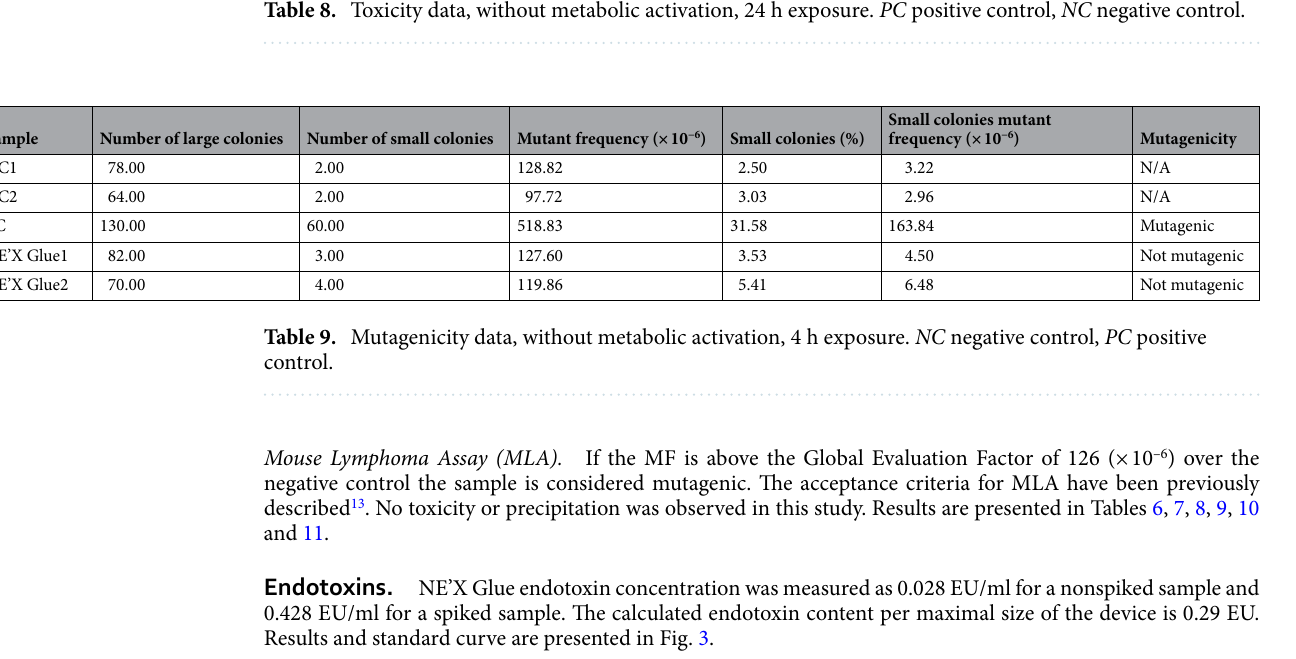
Table 8. Toxicity data, without metabolic activation, 24 h exposure. PC positive control, NC negative control.